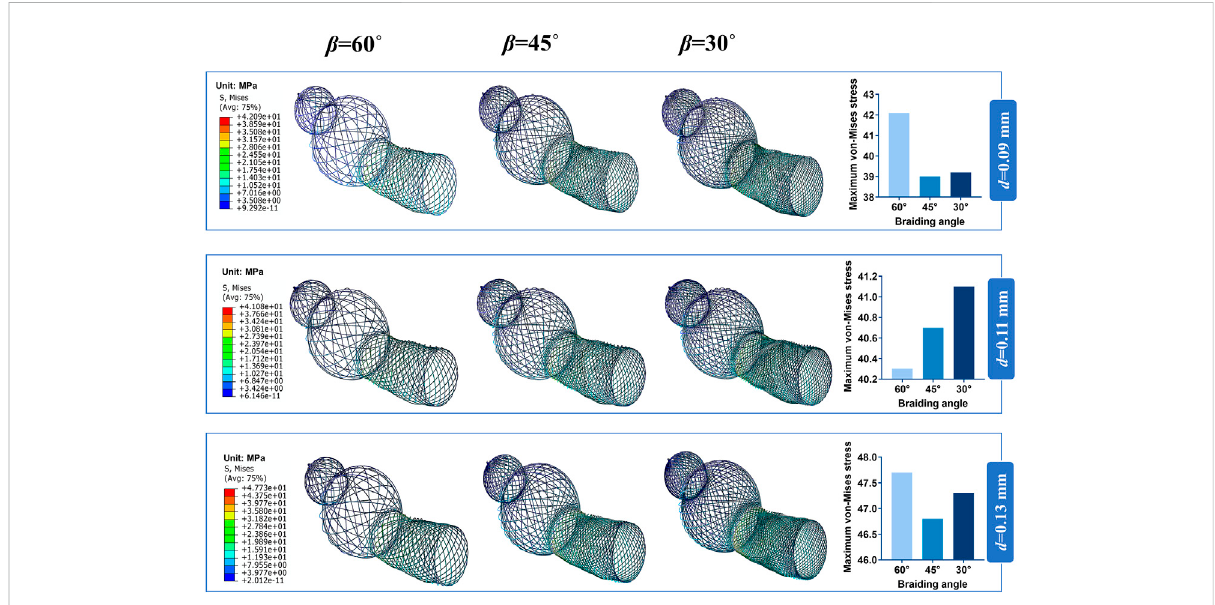
FIGURE 9 Contour plots of von-Mises Stress of the bended nasal stent: Stent model L.